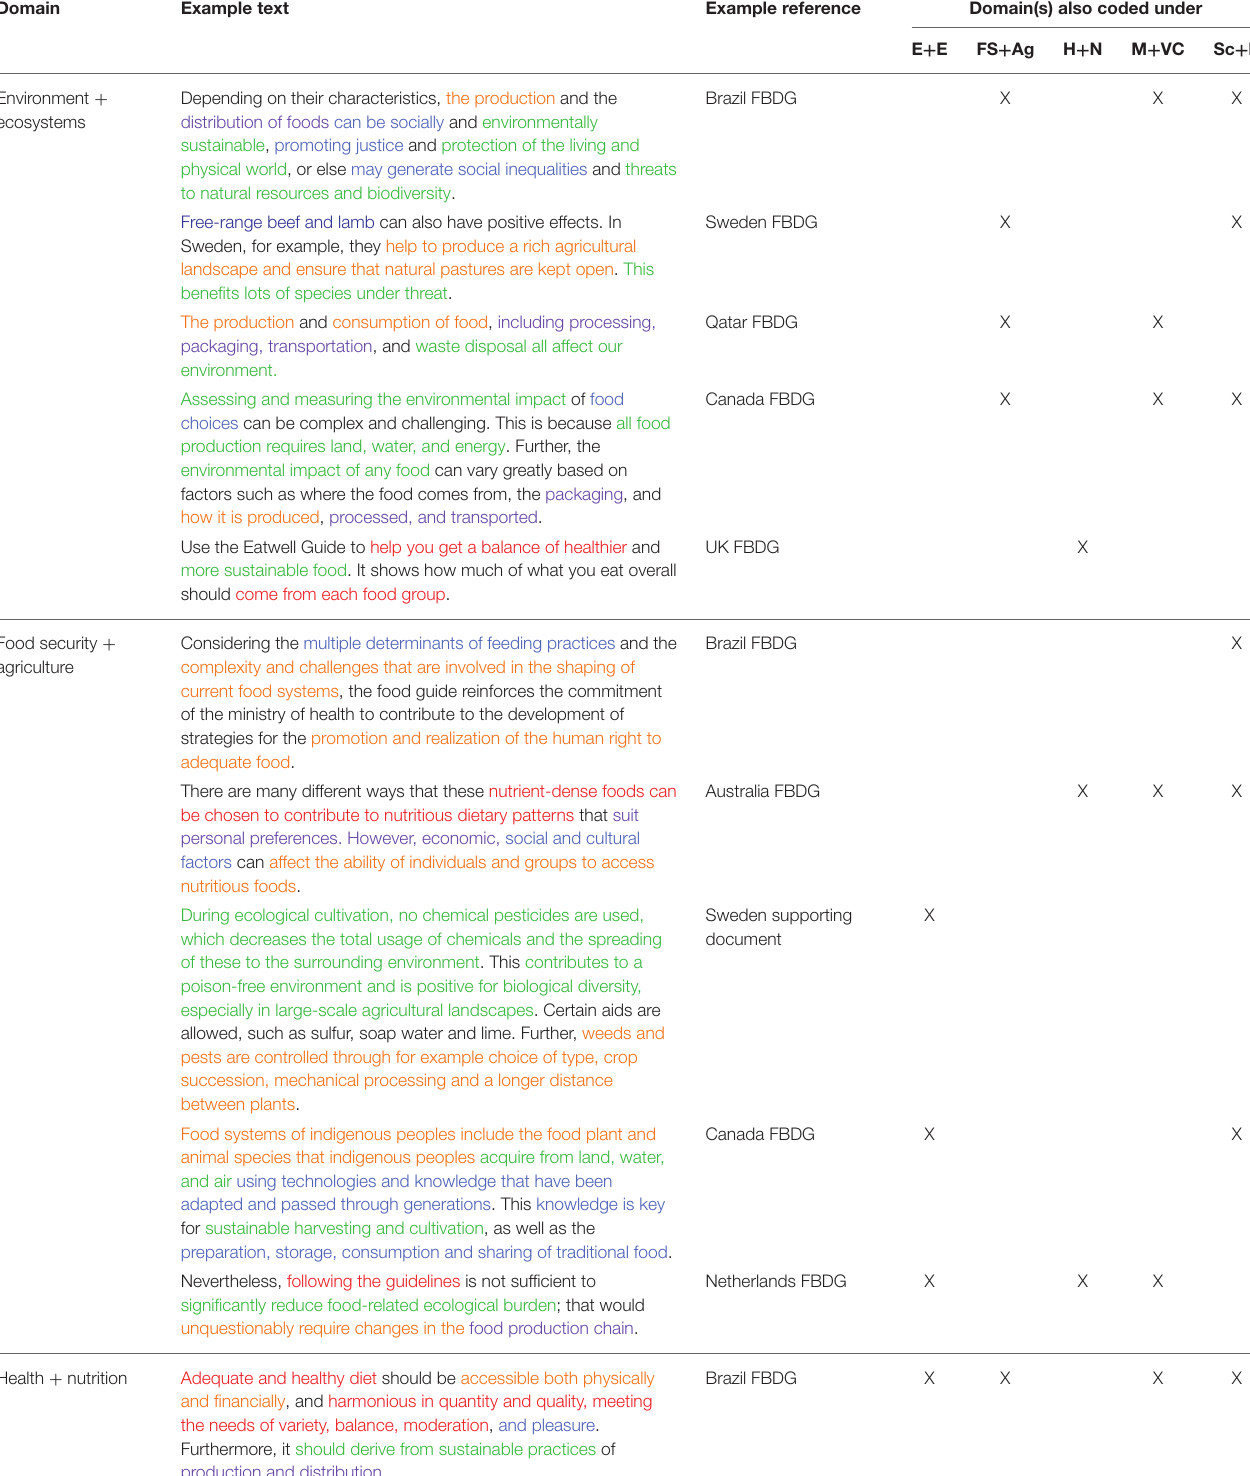
TABLE 2 | Selected examples (non-exhaustive) of text coded in each domain and an indication of the other domains each example is interconnected with; color is included: blue for sociocultural and political (Sc + P), green for environment and ecosystems (E + E), red for health and nutrition (H + N), orange for food security and agriculture (FS + Ag), and purple for markets and value chains (M +